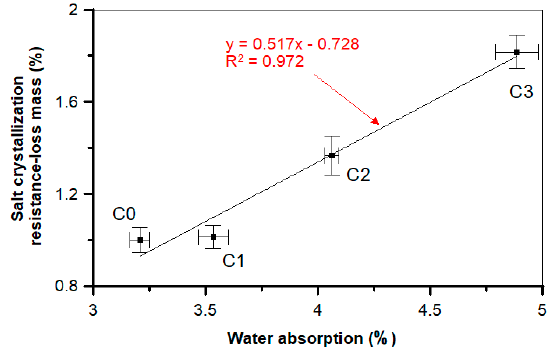
Figure 22. Relationship between the water absorption and salt crystallization resistance of a concrete.